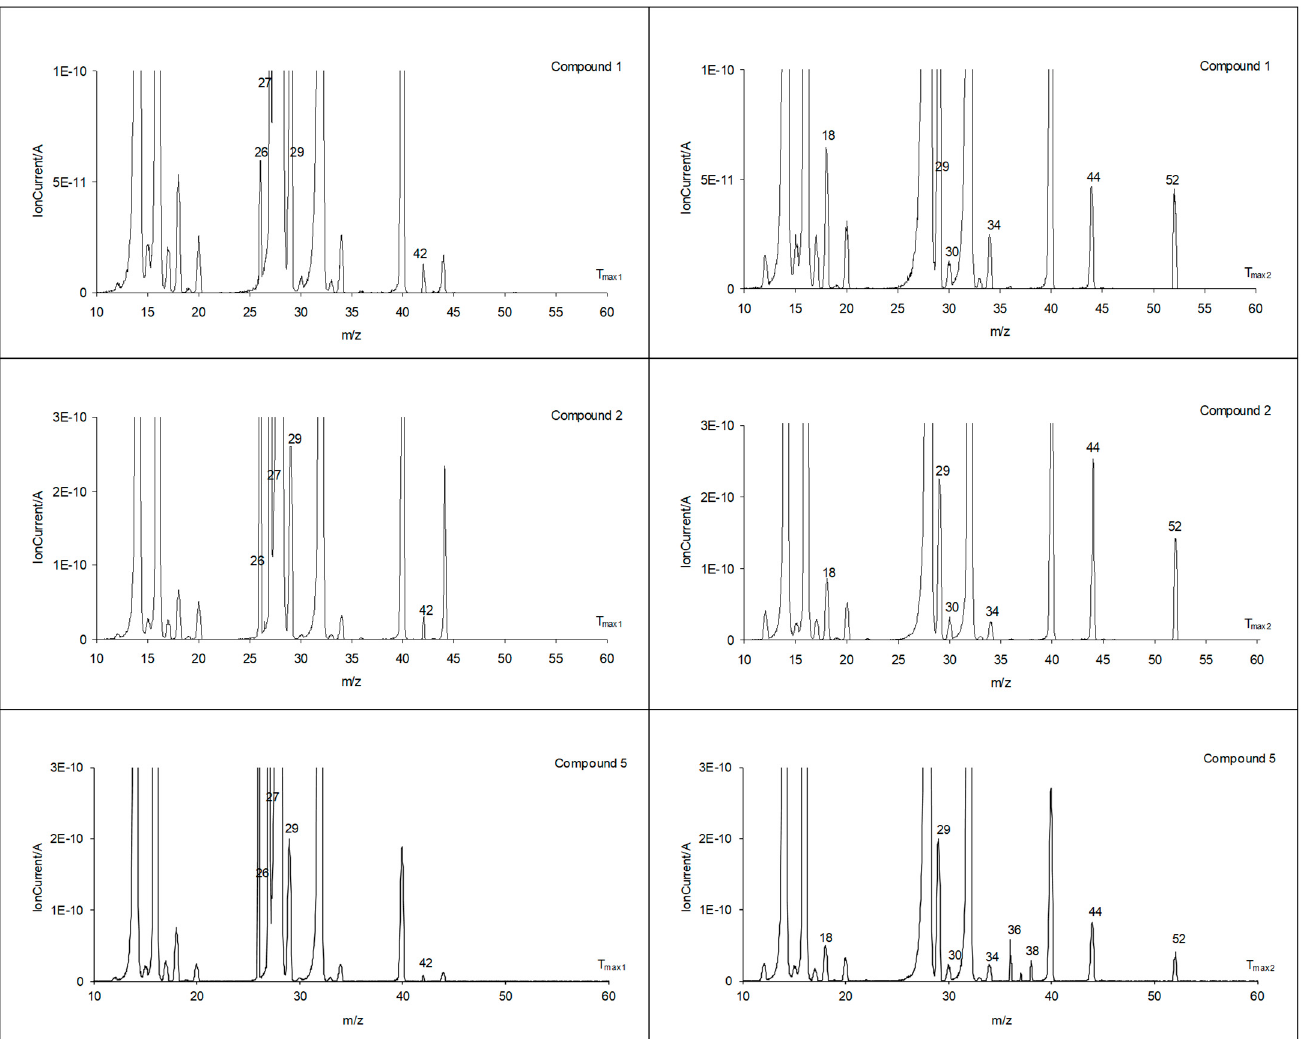
Figure 9 . The QMS spectra collected at T max1 and T max2 for the selected compounds in an air atmosphere.